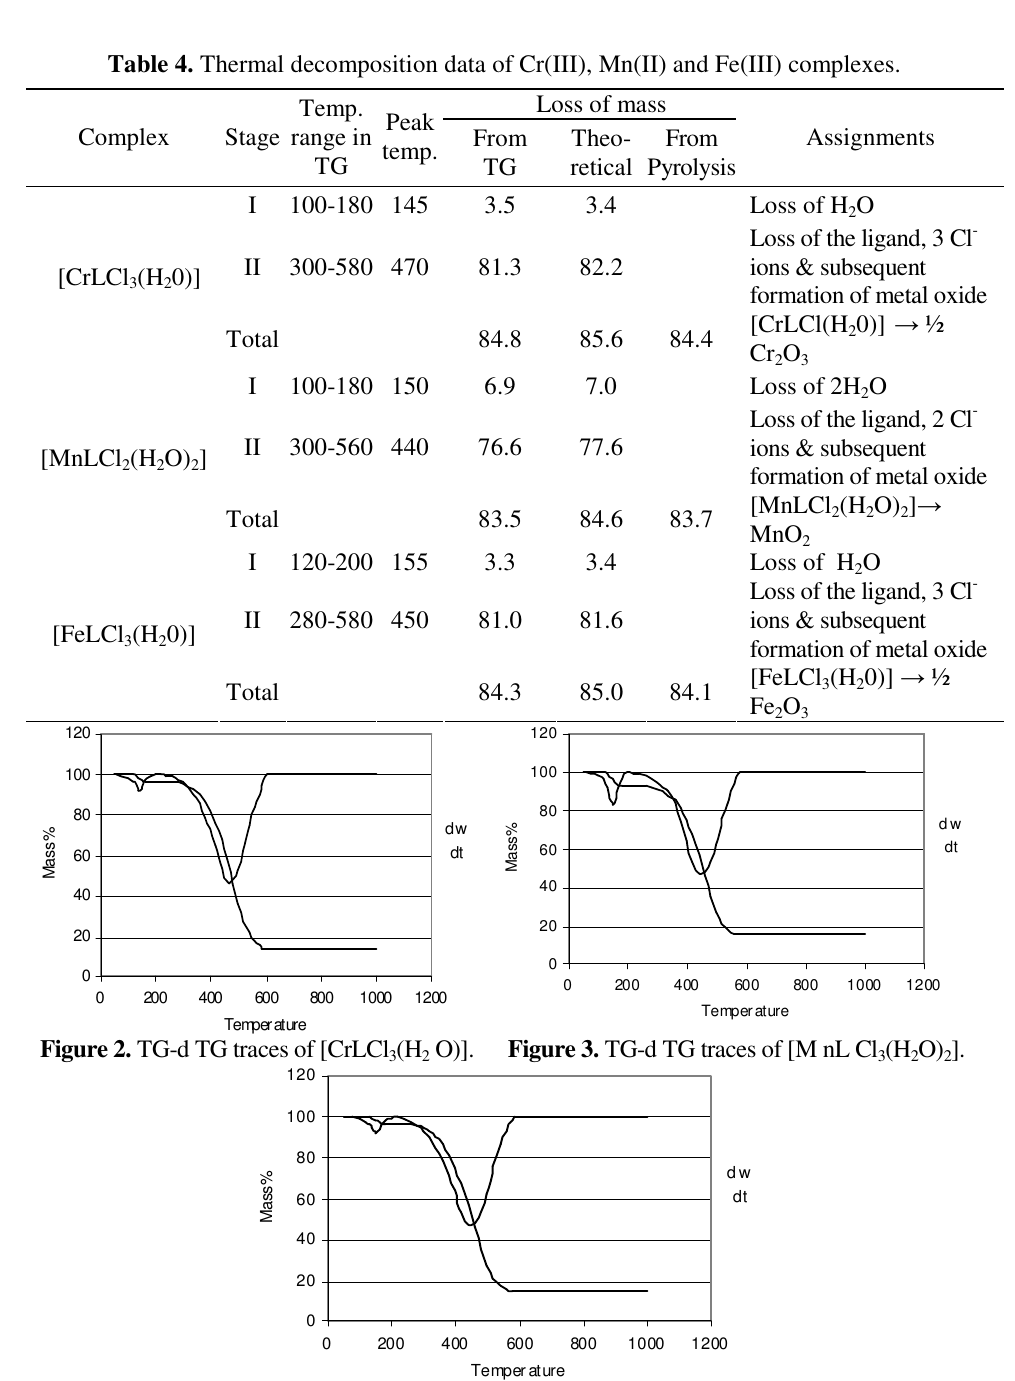
Figure 4. TG-d TG traces of [FeL Cl